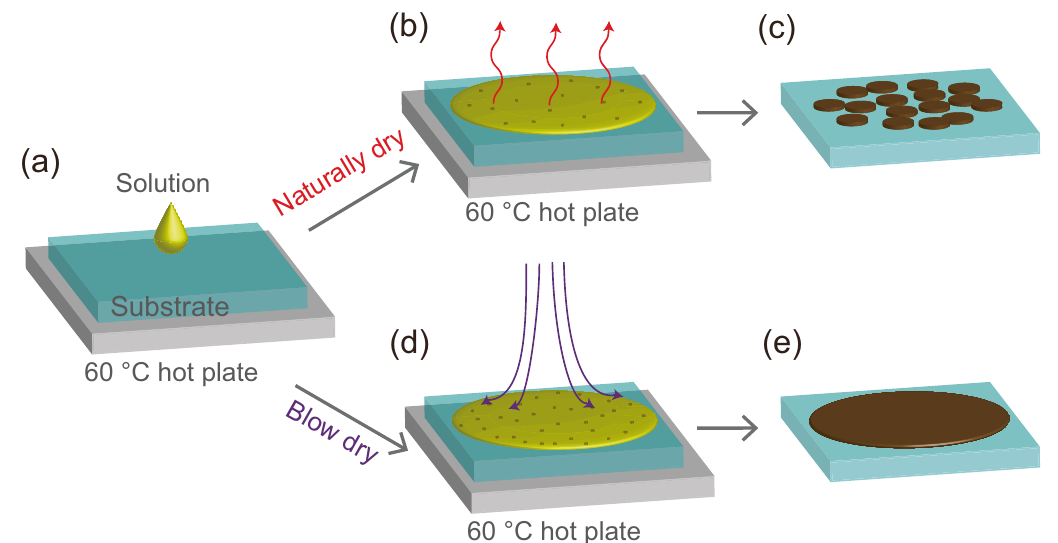
Fig. 1 Illustration of the natural drying and N 2 blow-drying processes used to prepare drop-cast quasi-2D perovskite fi lms. a The 2D perovskite precursor solution is drop-cast onto a heated substrate. b The solution spreads spontaneously on the substrate and dries naturally; the supersaturation and number of crystal nuclei are low due to the slow drying. c The crystal nuclei grow into large crystal grains during drying. d The fi lm spreads on the substrate and then an N 2 stream is used to dry the fi lm rapidly; the supersaturation and number of crystal nuclei is higher owing to the fast drying. e The crystal nuclei grow into a compact quasi-2D perovskite fi lm.